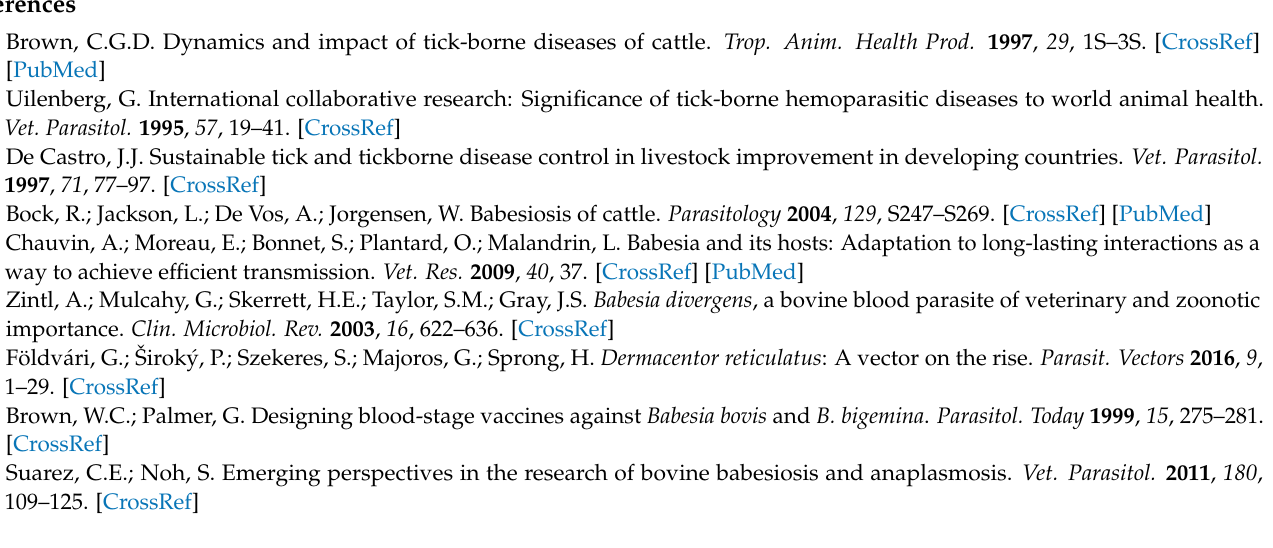
herein. Nucleotide similarity and percentage differences are given above and below the diagonal, respectively. Table S2: Pairwise comparison of 18S rRNA nucleotide amplicon sequence variant sequences belonging to Babesia species ( B. bovis , BBo1-Bbo14; B. occultans , BOC1; B. bigemina , BBi1- the diagonal,